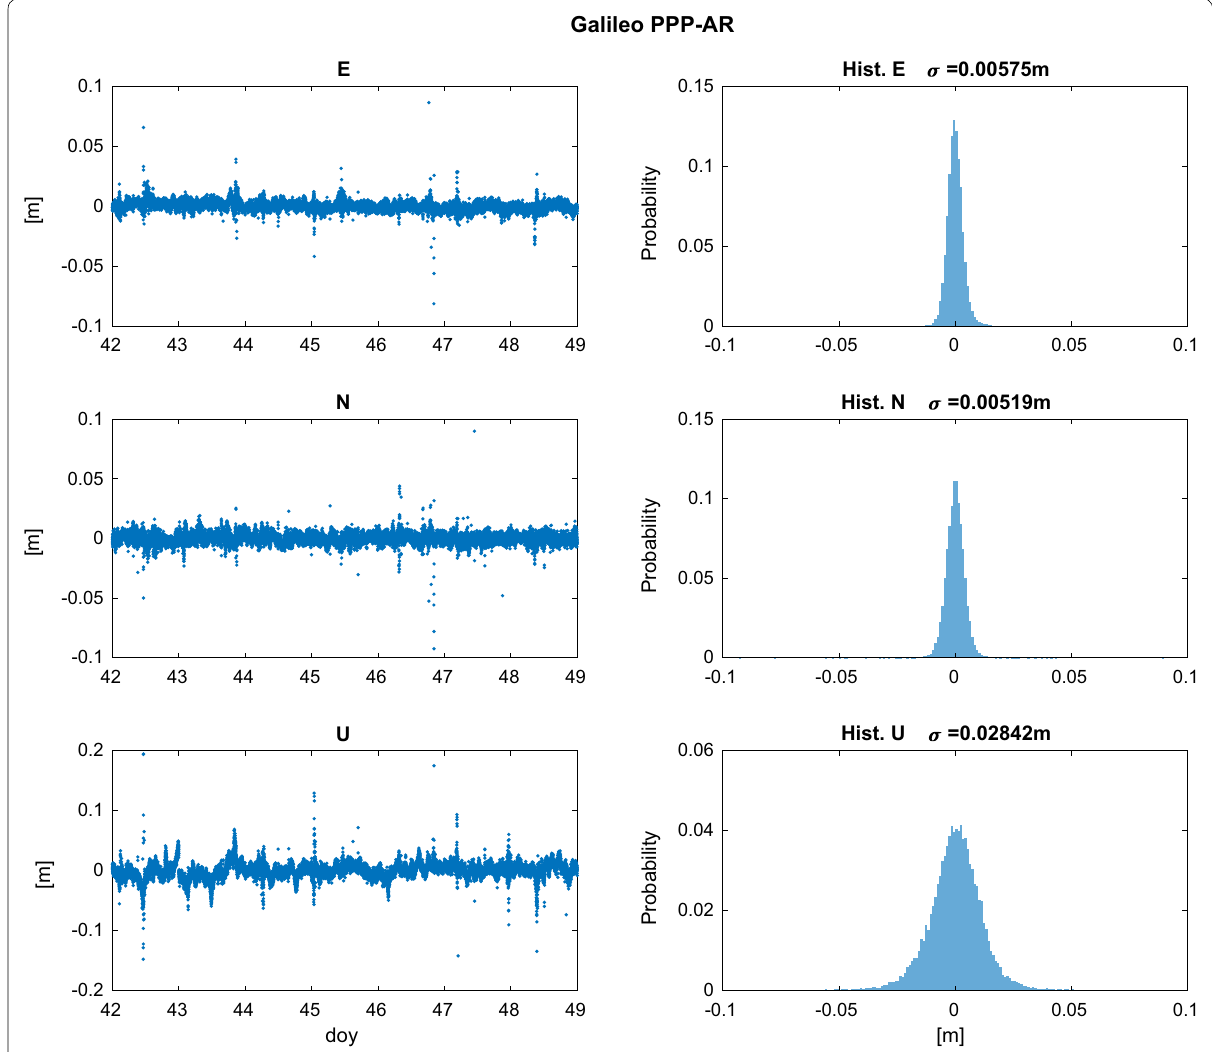
Fig. 3 Galileo-only PPP-AR solutions of BRUX station in East (E), North (N) and Up (U) components (left) and their respective histograms with 1 σ values